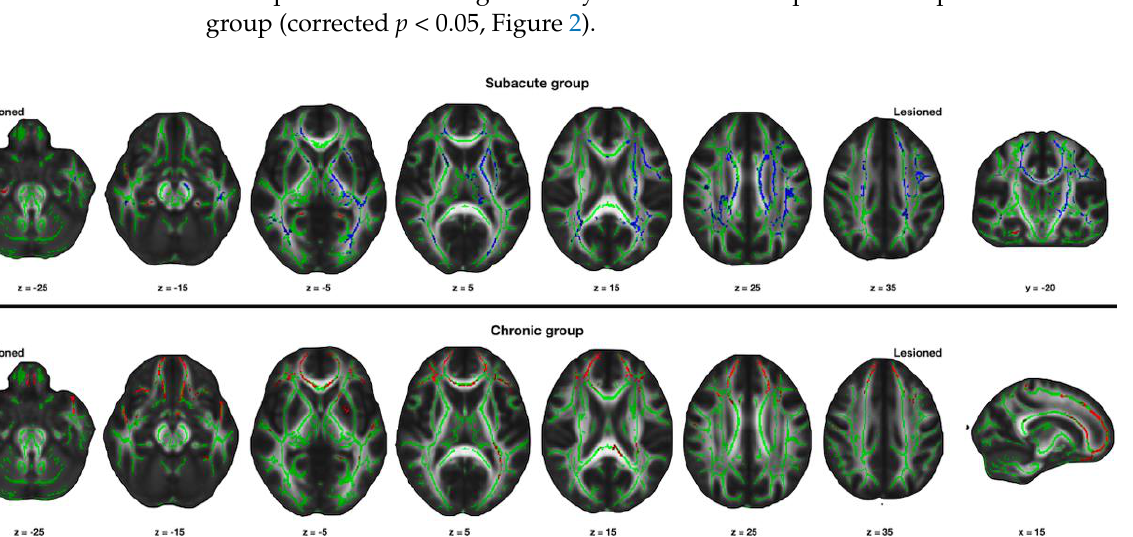
Figure 1. Lesion overlapping maps of the subacute and chronic groups. The color scale indicates the number of overlapping lesions across the patients. Lesioned: Lesioned hemisphere; Non-lesioned: